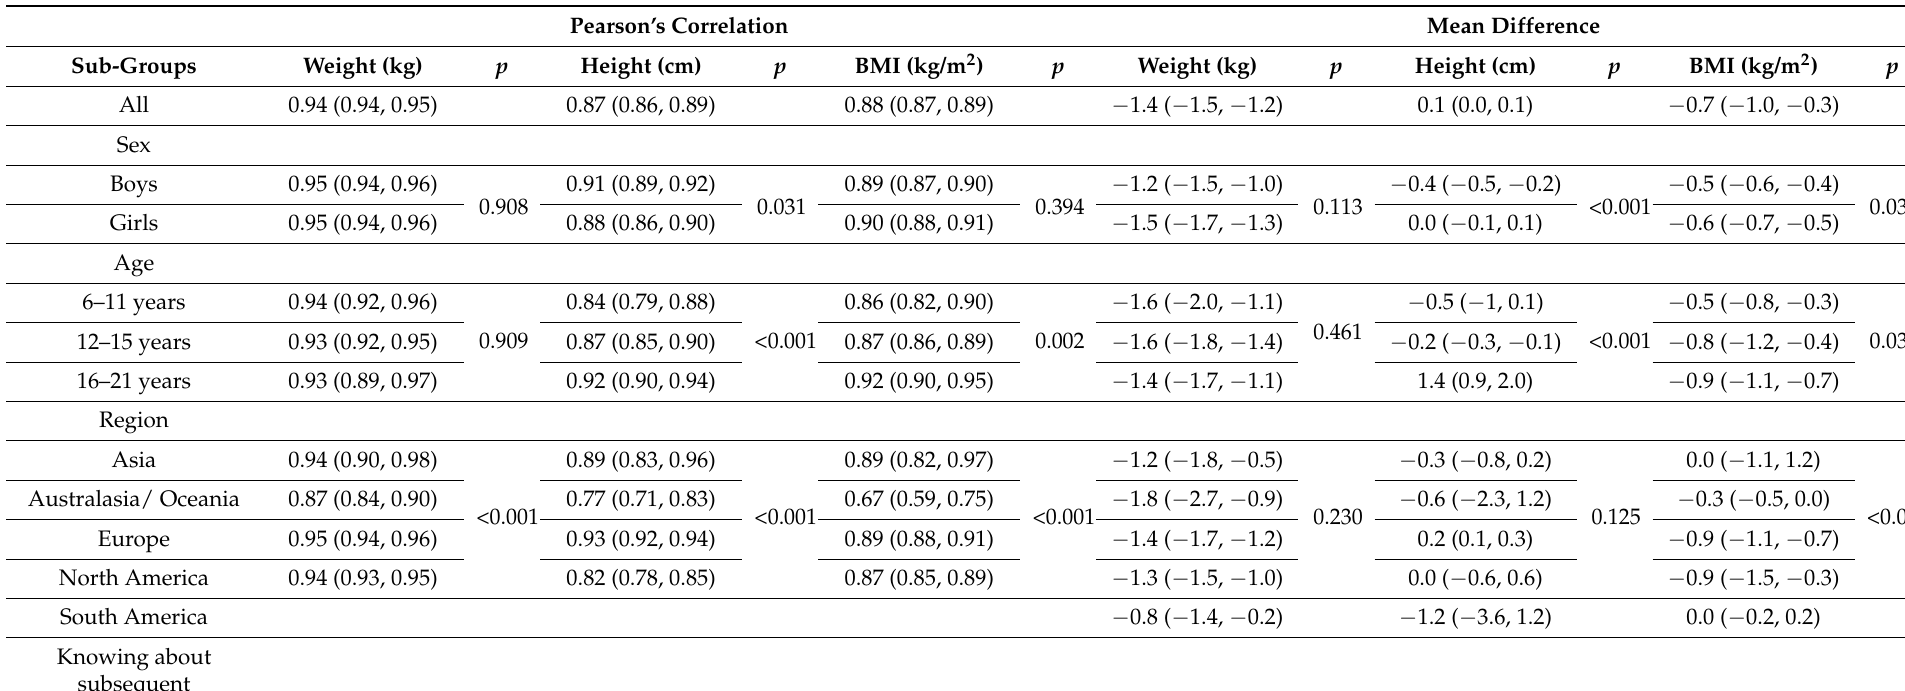
Table 5. Results of the meta-analyses (mean (95% CI)). p -values are for differences between